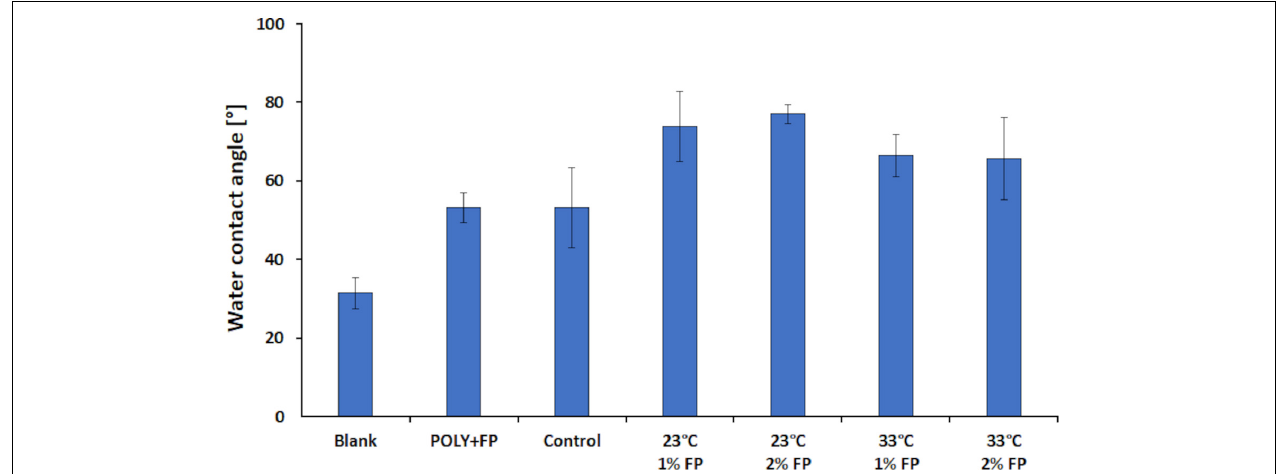
FIGURE 7 | Results for the water contact angle measurement for the laccase catalyzed coupling of FP onto LS. All samples were done at pH 7. The blank was done without enzyme at 23 ◦ C and with 1% (w/v) FP added. In the POLY + FP sample, FP was added after the polymerization reaction was finished. The control sample was done with enzyme at 23 ◦ C and without FP